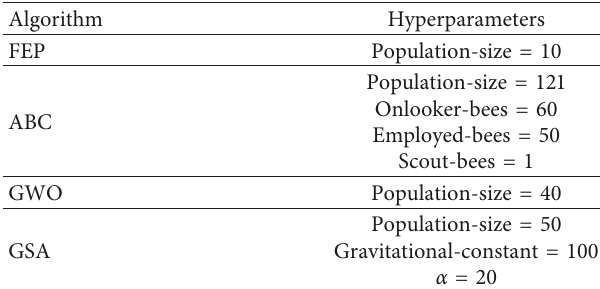
Table 10: Hyperperameter setting for compared algorithms.